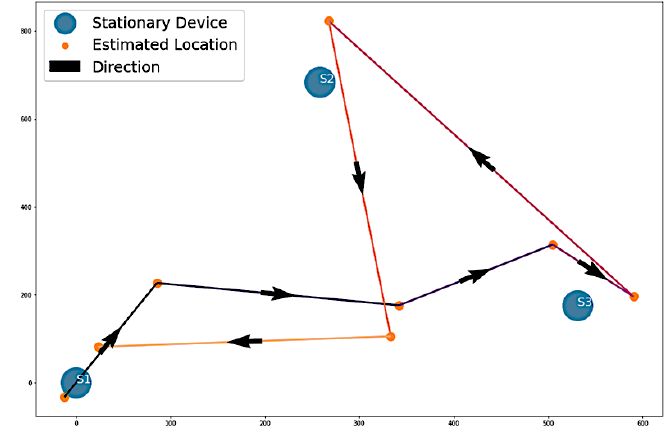
Figure 9. Algorithm 1’s estimation of Path 1.